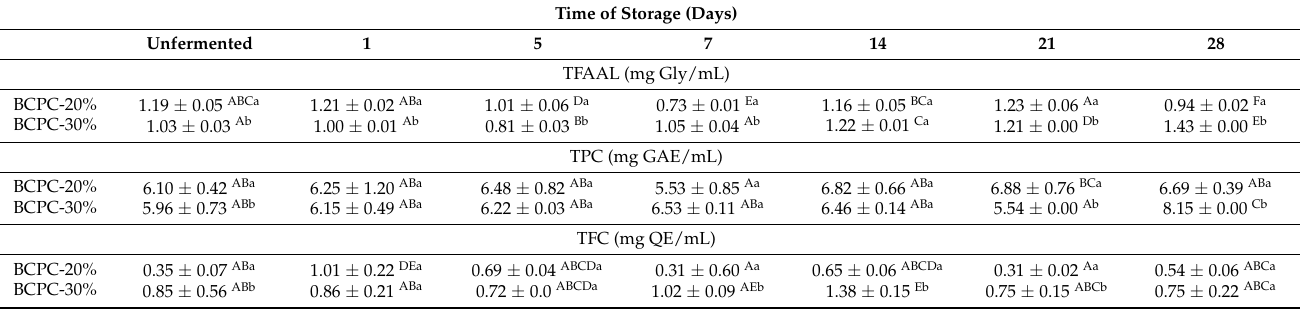
Table 2. Total free amino acid level (TFAAL), total polyphenolics content (TPC), and total flavonoids content